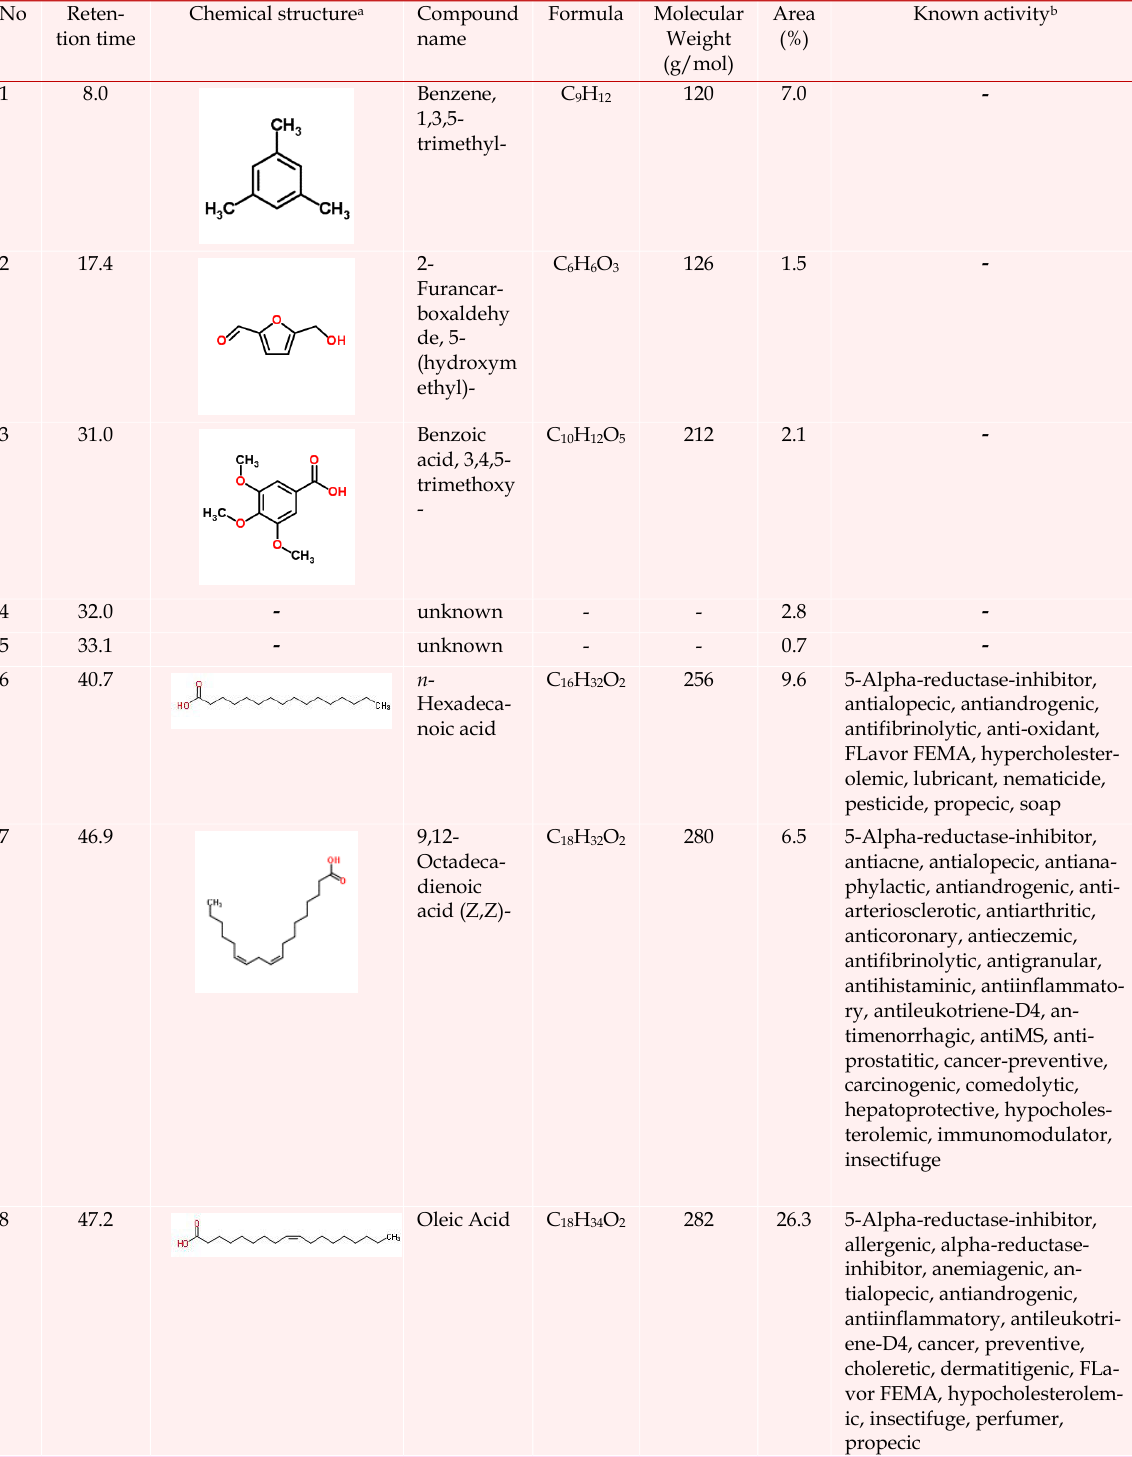
Major chemical components of F. hirsuta according to the GC-MS